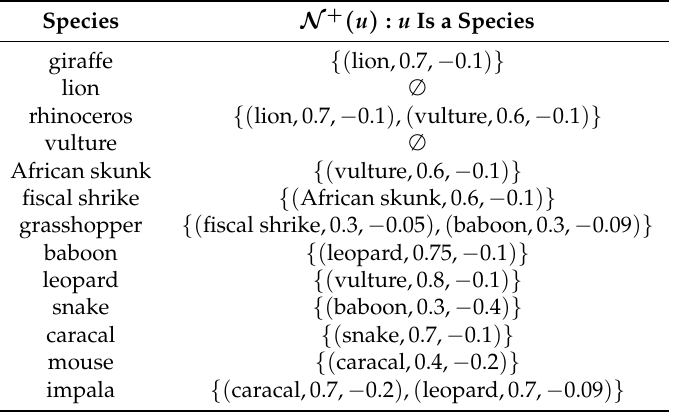
Table 5. Bipolar fuzzy out neighborhoods.